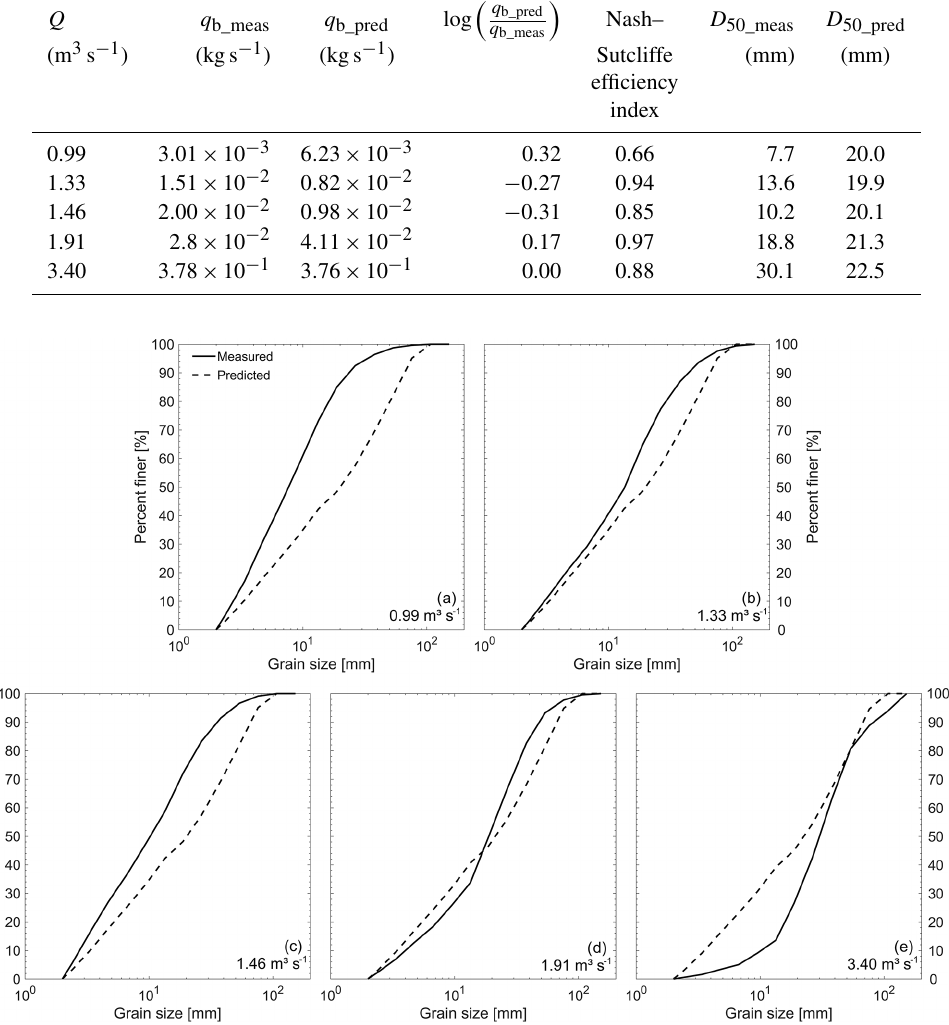
Figure 7. Measured and predicted bed load grain size distributions for all events used in the calibration of Eq. (8). Flow discharges are shown in the lower-left corner of each